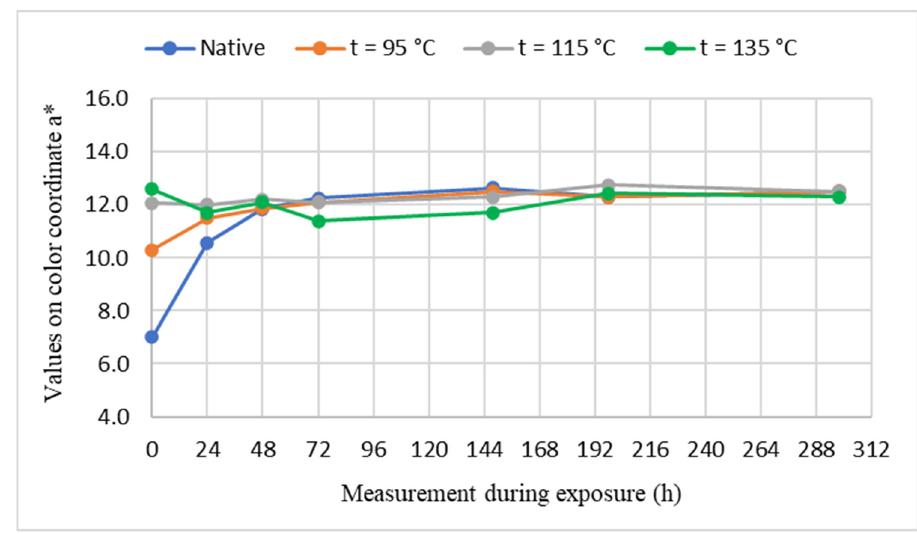
Figure 3. The course of changes of values on the coordinate of red color and a* in the process of UV irradiation of samples of unsteamed and steamed maple wood.